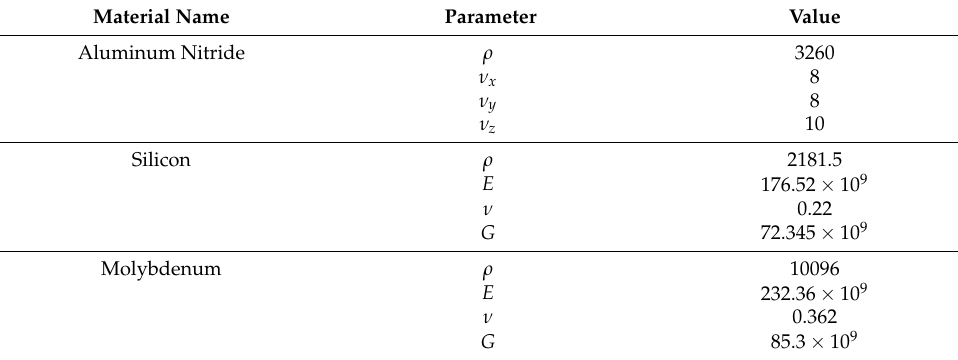
Table 9. Material parameters